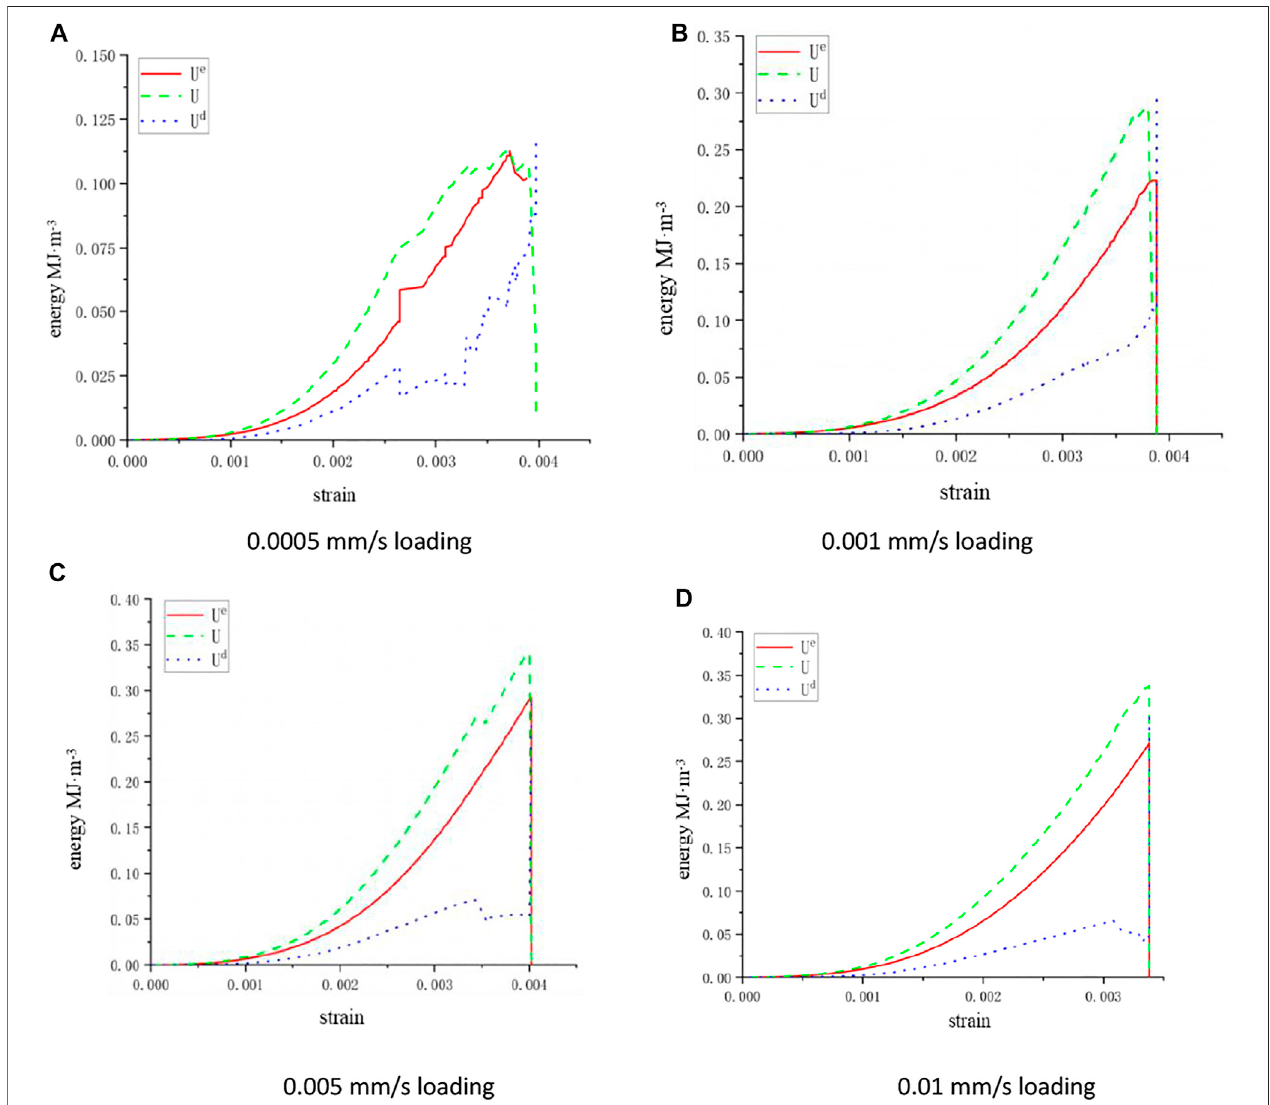
FIGURE10| Energyevolutioninphosphate rockduringdamageunderdifferentloadingrates. (A) 0.0005 mm/sloading, (B) 0.001 mm/sloading, (C) 0.005 mm/s loading, and (D) 0.01 mm/s loading.